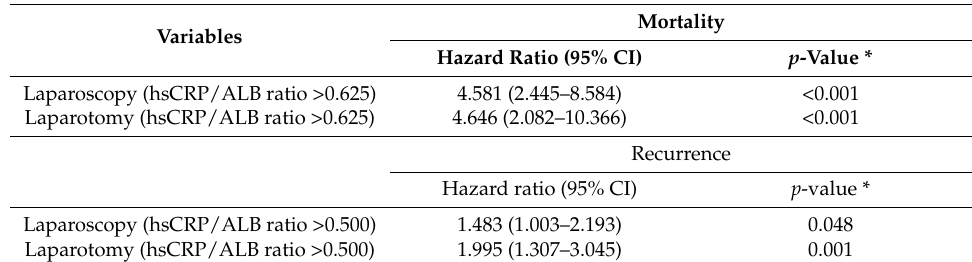
Table 4. Cox proportional hazard model for survival or recurrence after HCC surgery according to procedures (laparoscopy and